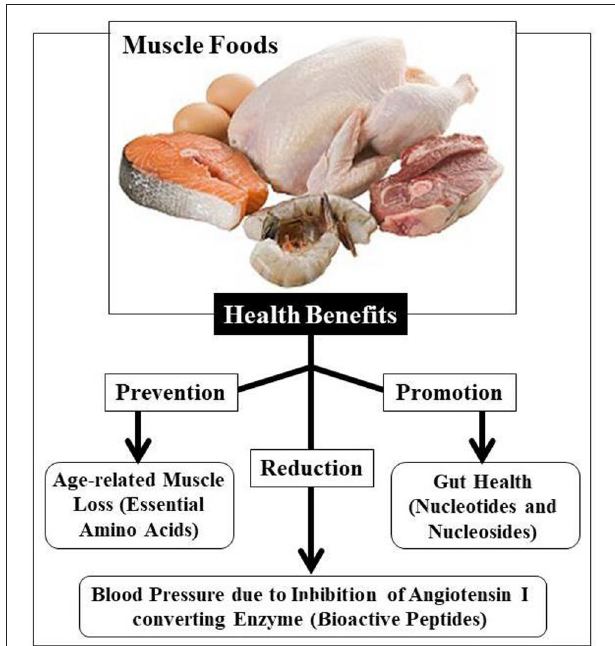
FIGURE 6 | Health benefits of muscle food